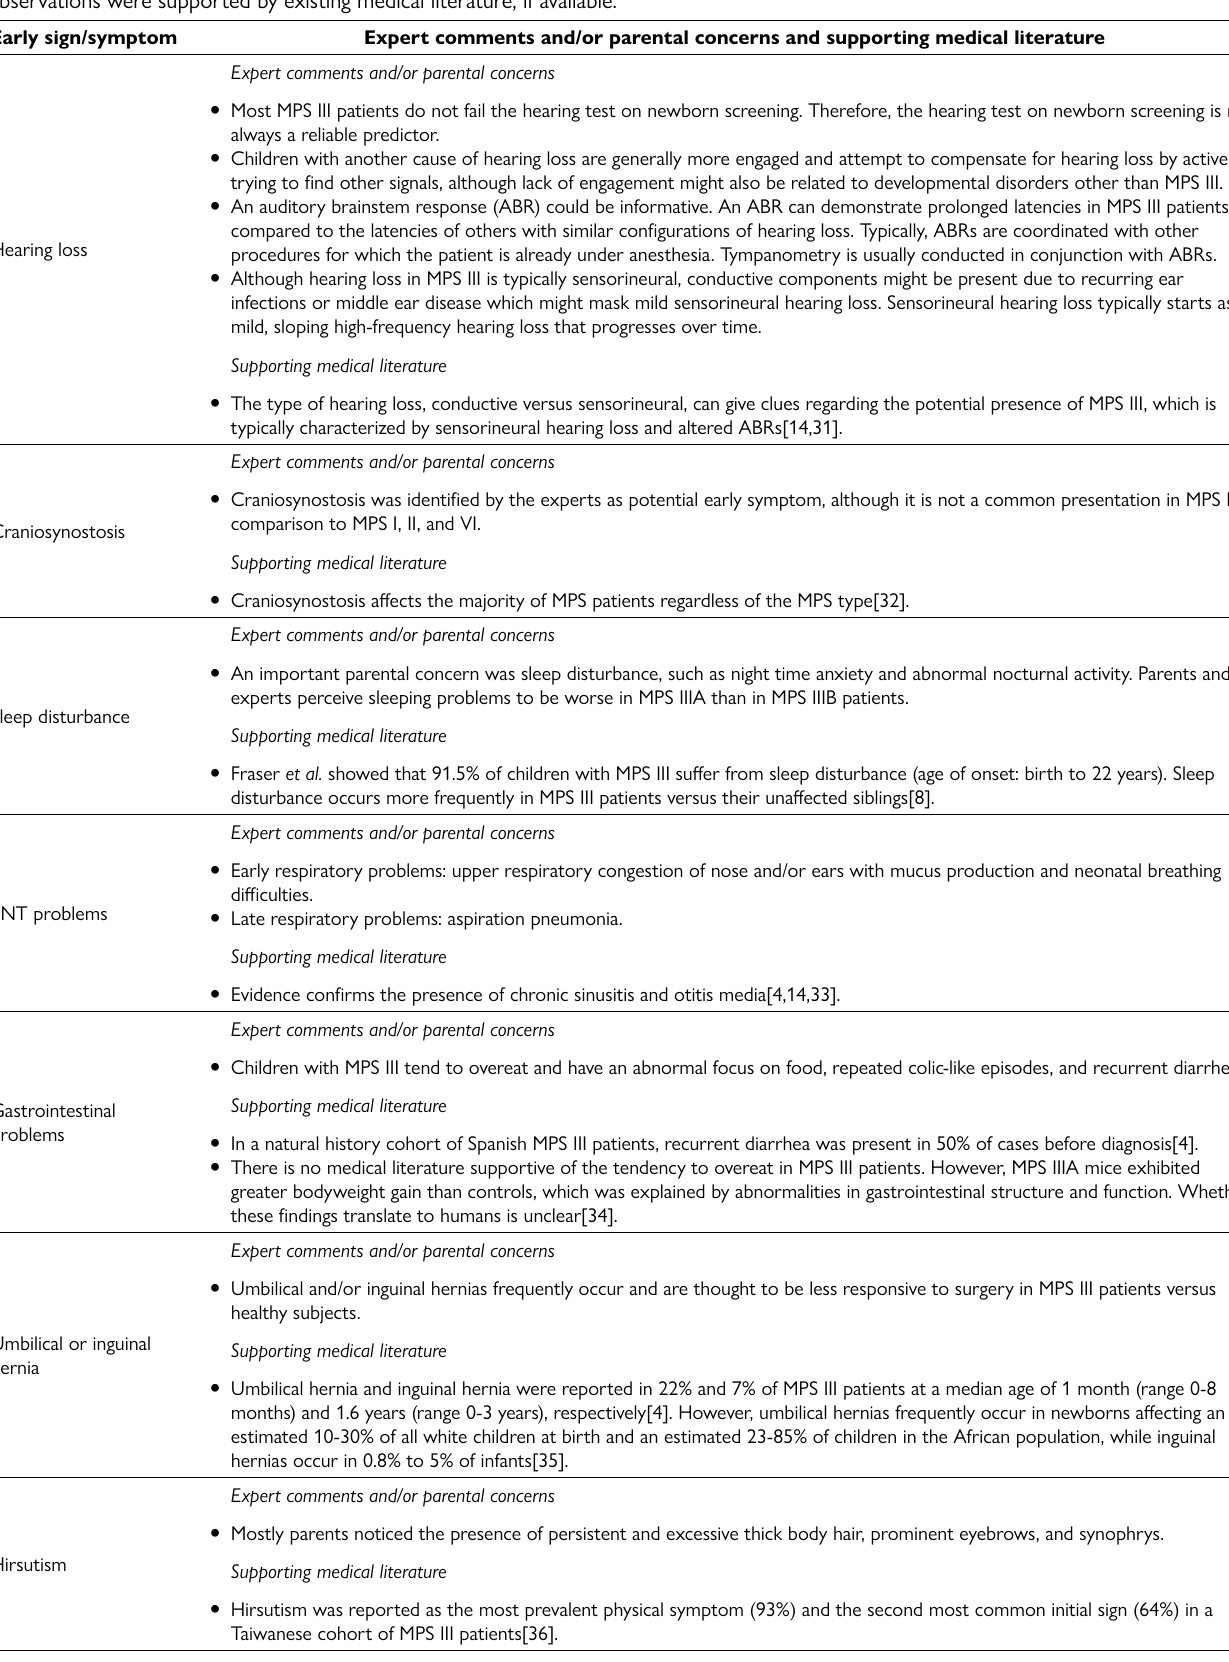
Table 1. Early signs and symptoms of MPS III patients identified by the experts and parents through the expert system approach. The experts’ observations were supported by existing medical literature, if